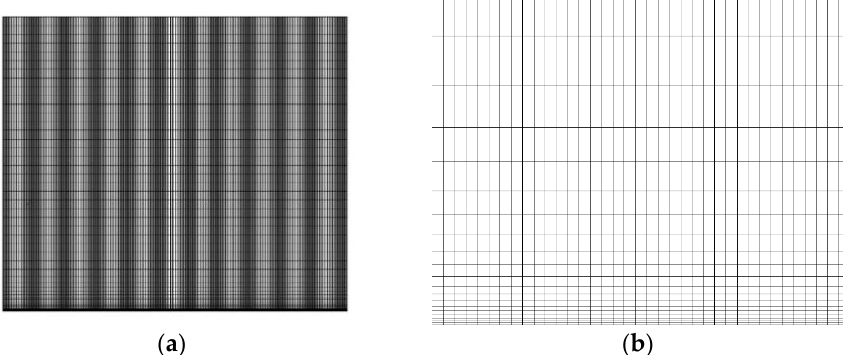
Figure 3. The meshing of the smooth plate. ( a ) smooth plate mesh; ( b ) smooth flat surface near-wall mesh.